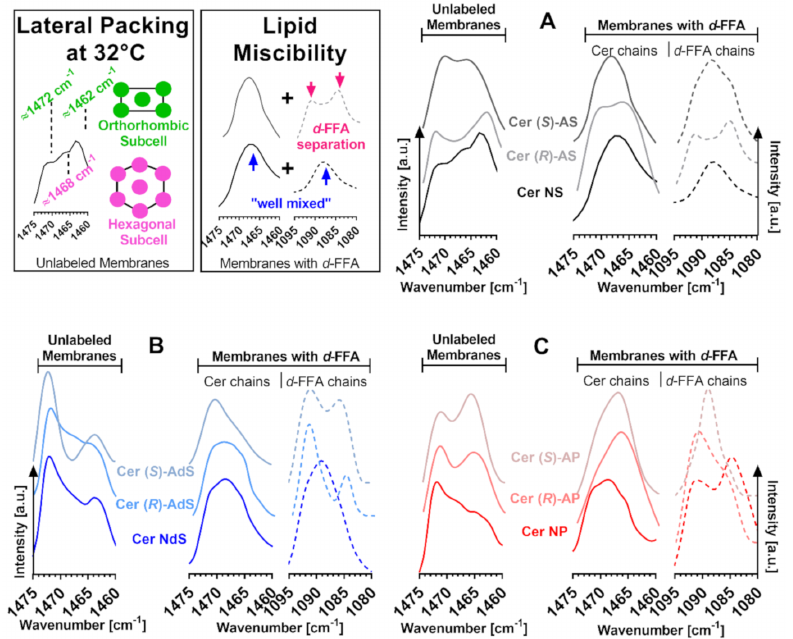
Figure 4. FTIR spectra (methylene scissoring vibrations) of model SC lipid membranes containing the studied Cers: sphingosine Cers (Cer NS, Cer ( R )–AS, or Cer ( S )–AS; Panel ( A ), dihydrosphingosine Cers (Cer NdS, Cer ( R )–AdS, or Cer ( S )–AdS; Panel ( B ), phytosphingosine Cers (Cer NP, Cer ( R )–AP, or Cer ( S )–AP; Panel ( C ), ( d )–FFAs, Chol, and CholS. The first graphs in each panel show the behavior of the membrane with unlabeled lipids, i.e., both Cer and FFA chains. The second and third graphs in each panel show the behavior of the membrane with d -FFAs, where the second graph shows the CH 2 vibrations of Cer chains, and the third graph shows the CD 2 vibrations of d -FFAs. The splitting of the scissoring band into a doublet is indicative of orthorhombic chain packing. The thermal evolution of the prominent bands is given in the supporting information (Figure